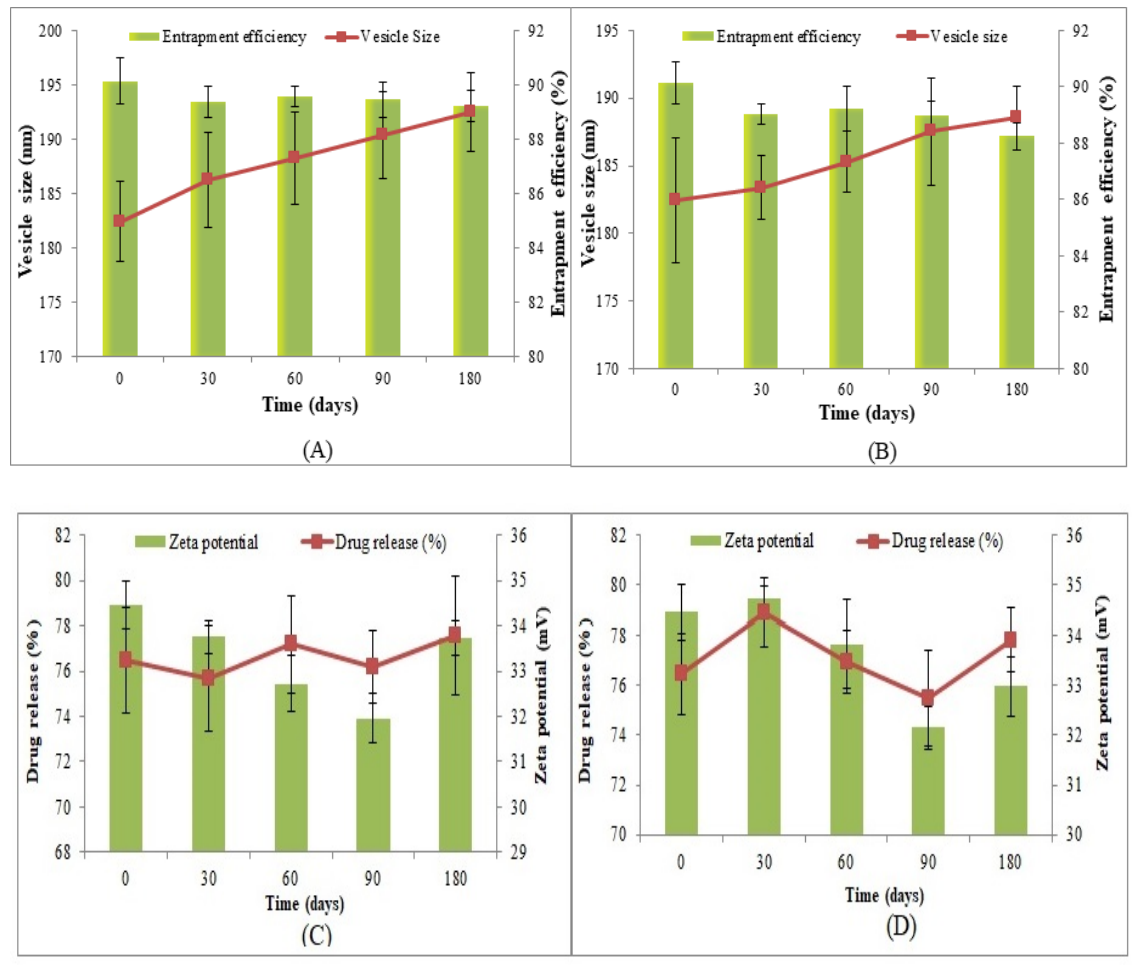
Figure 4. Stability study of CIP-BLO-opt at 4 ±0.5 °C ( A , C ) and 25 ± 2 °C/60 ± 5% RH ( B , D ). The effect was observed on vesicle size and EE ( A , B ) and drug release and zeta potential ( C , D ). Data represented as mean ± SD, n = 3.